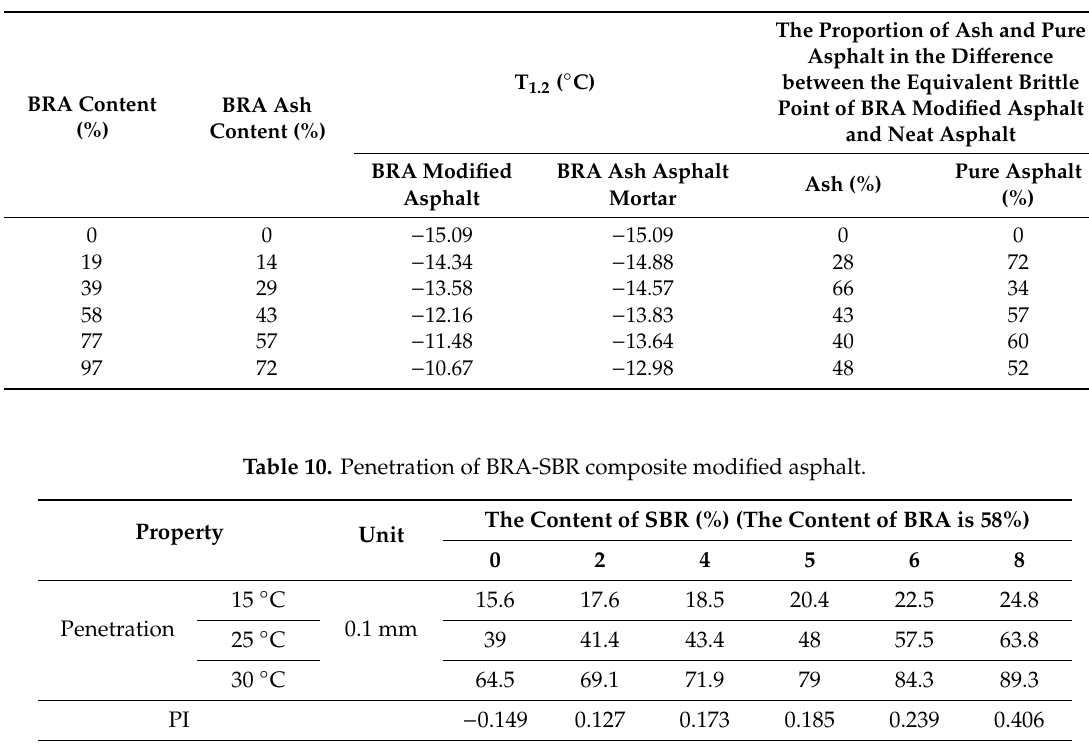
Table 9. Percentage of equivalent brittle point of di ff erent components in BRA.